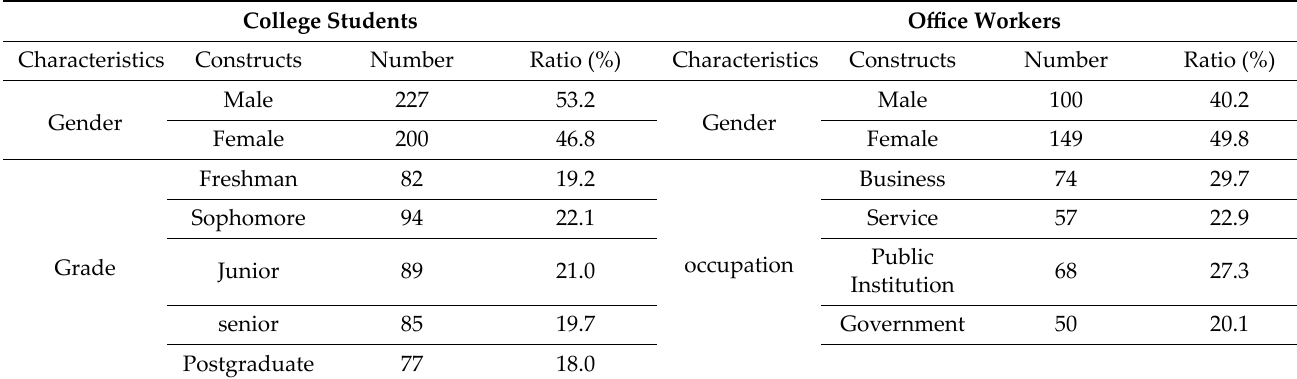
Table 2. Demographic characteristics in this